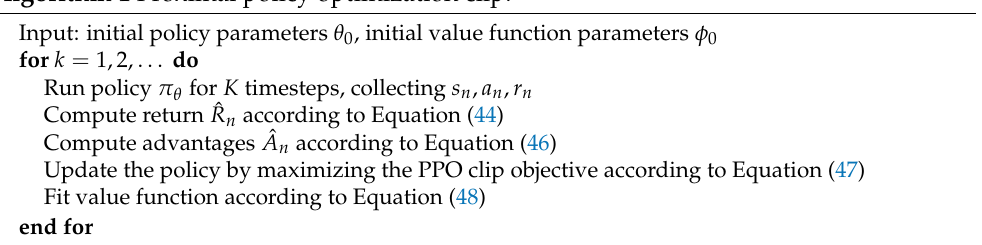
Algorithm 1 Proximal policy optimization